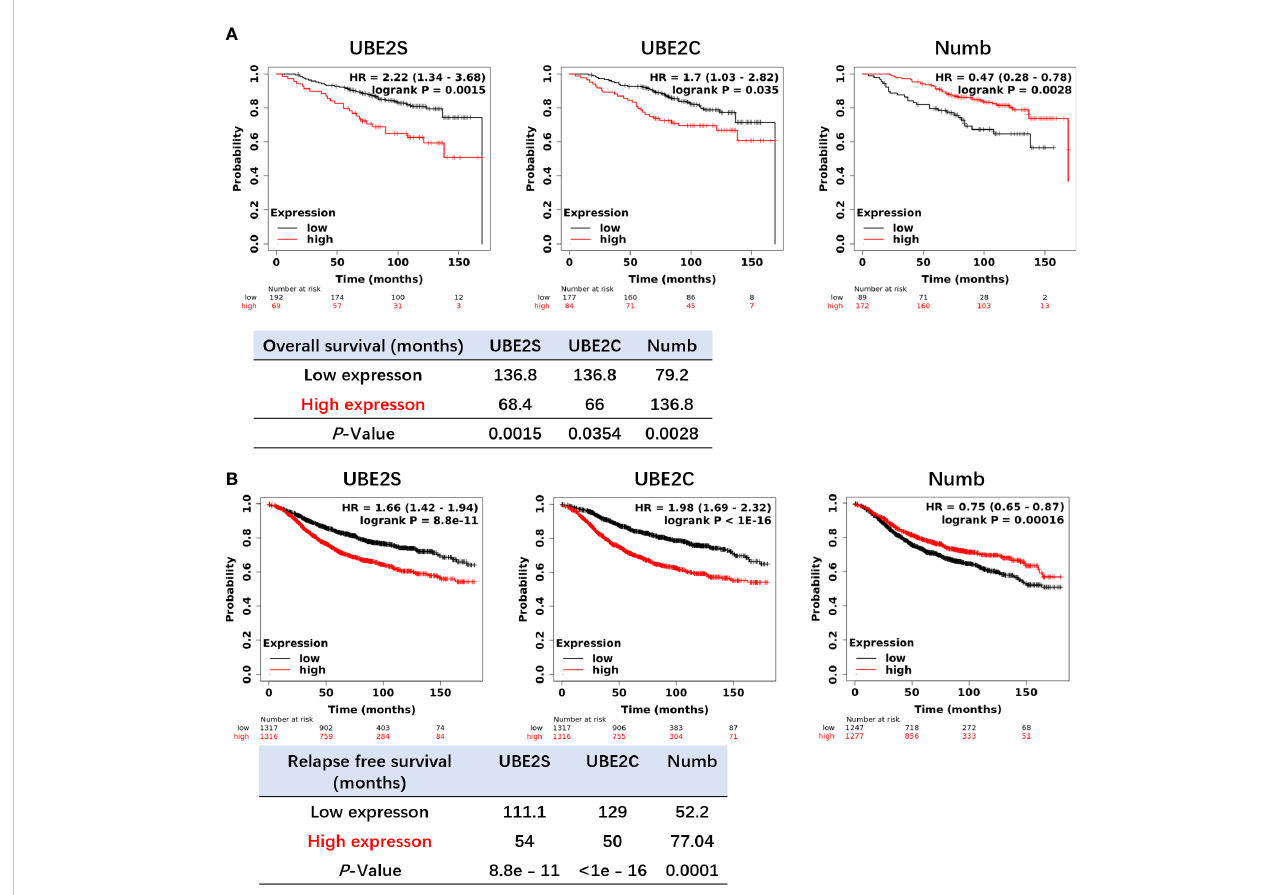
FIGURE 7 Increased expression of UBE2S and UBE2C and reduced expression of Numb are related to shorter OS (A) and RFS (B) in ER+ breast cancer patients by the Kaplan – Meier plotter survival analysis. The p -value and survival time were indicated in the respective